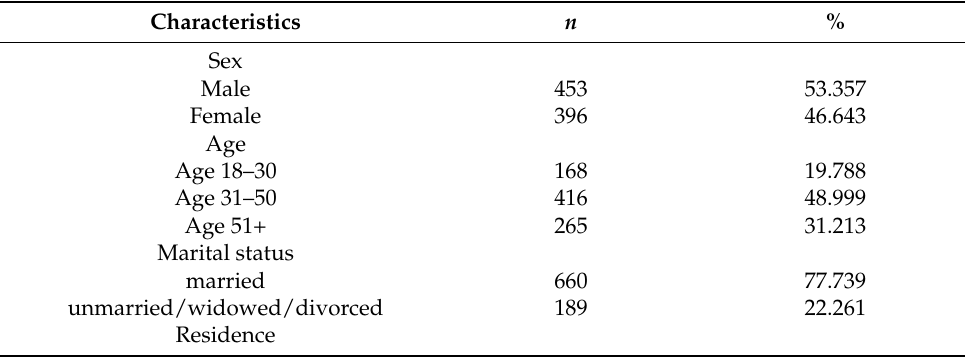
Table 3. Characteristics of the study sample ( n =